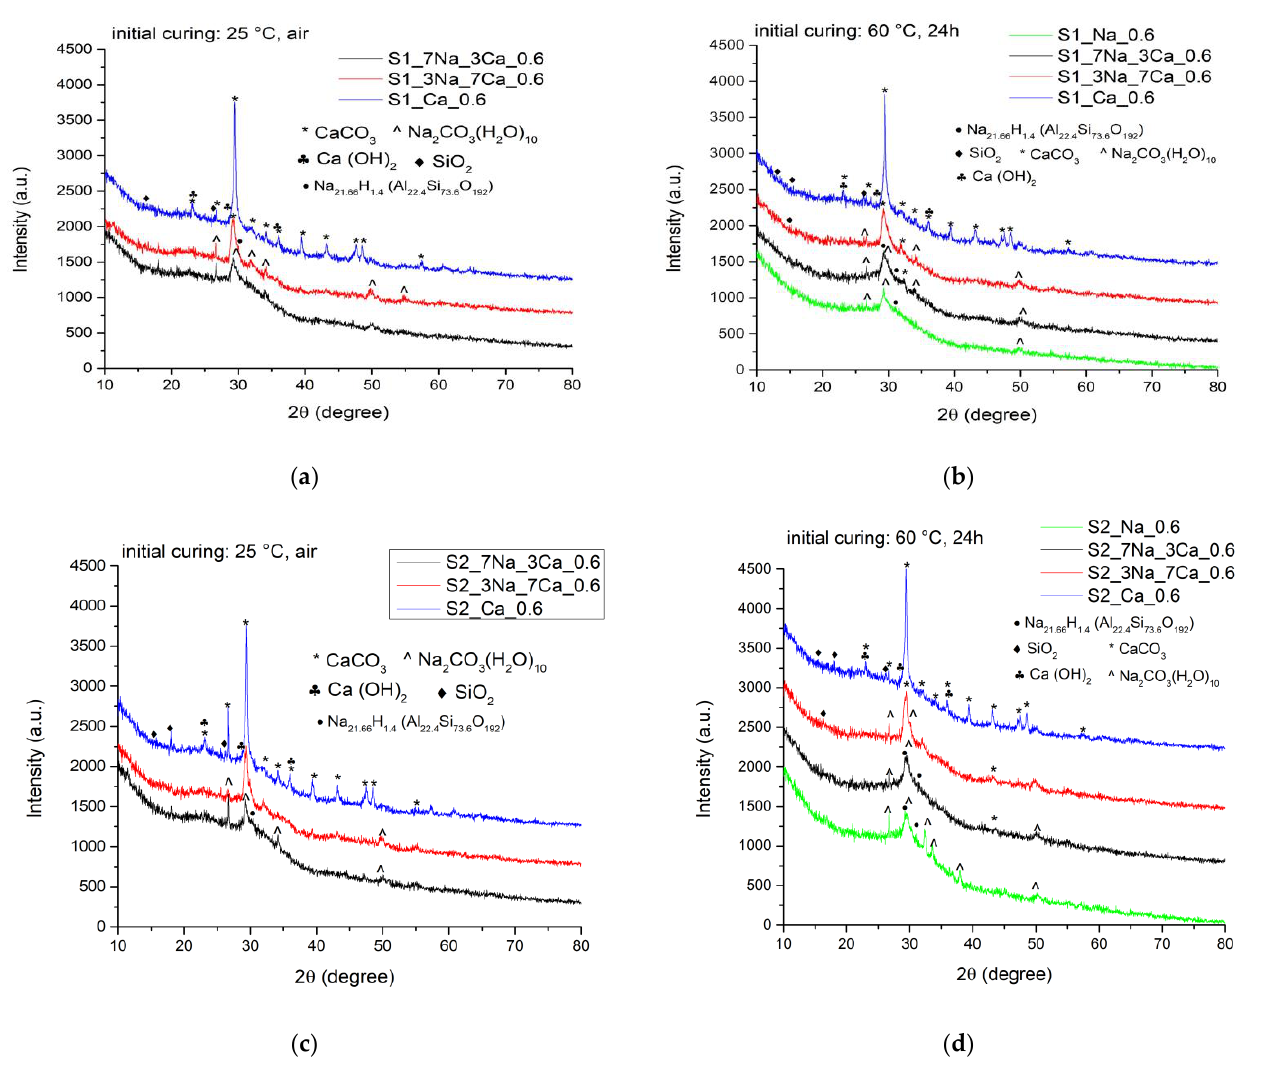
Figure 2. XRD patterns recorded after 7 days of hardening for: ( a ) samples obtained with S1 glass powder cured at 25 °C ; ( b ) samples obtained with S1 glass powder cured first at 60 °C for 24h and then at 25 °C; ( c ) samples obtained with S2 glass powder cured at 25 °C ; ( d ) samples obtained with S2 glass powder cured first at 60 °C for 24h and then at 25 °C.